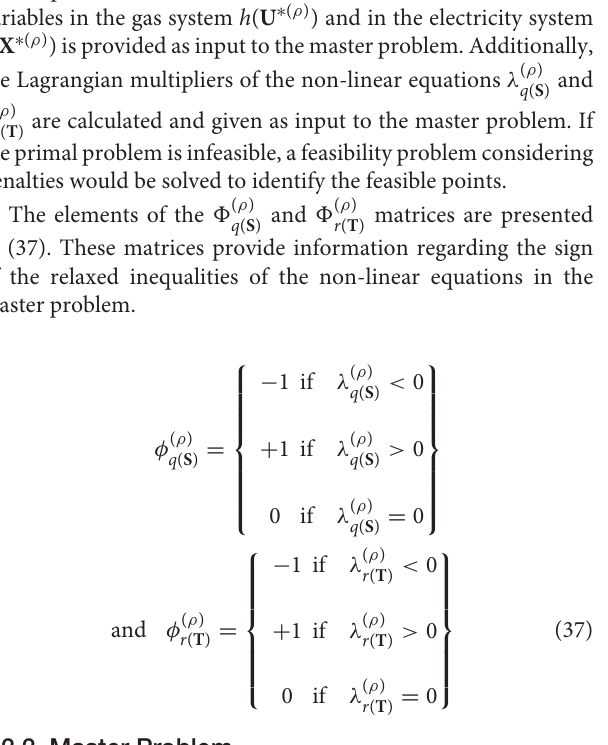
TABLE 1 | Generation mix in GB